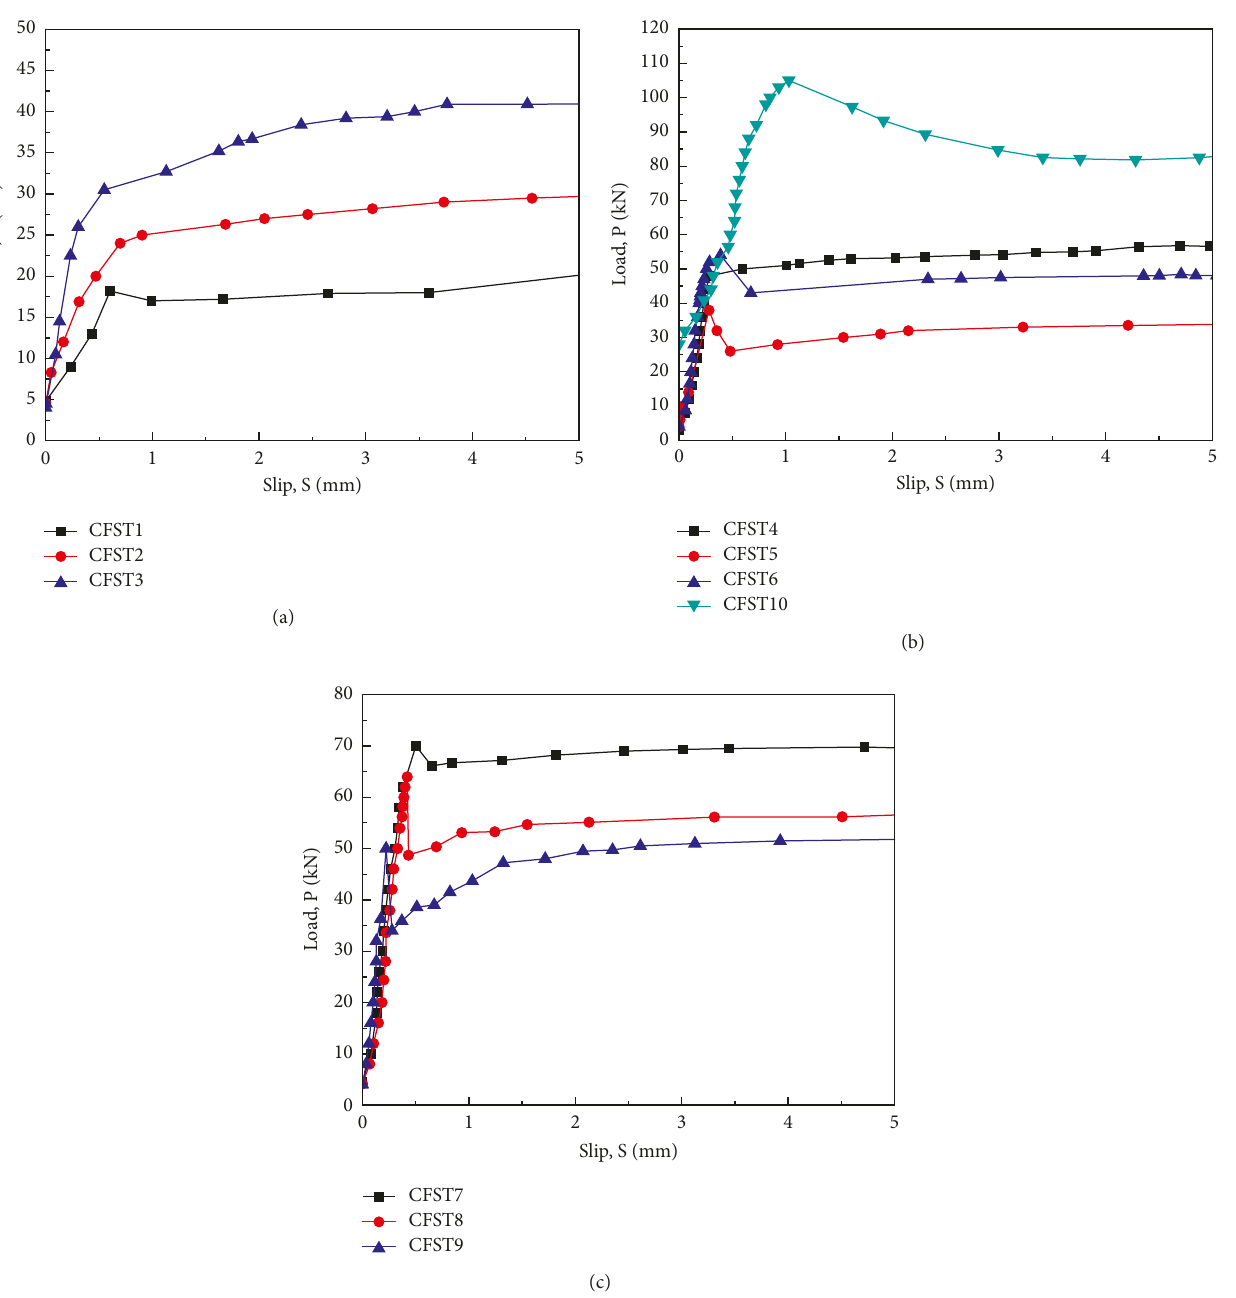
Figure 7: P-S curves of the loading